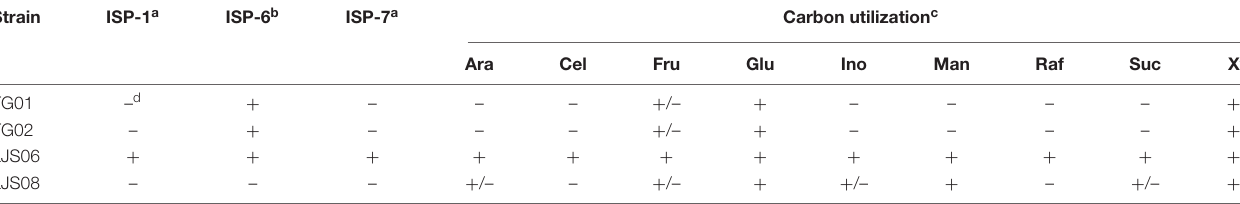
TABLE 4 | Capability for carbon utilization and melanin and H 2 S production for the four Streptomyces strains. Strain ISP-1 a